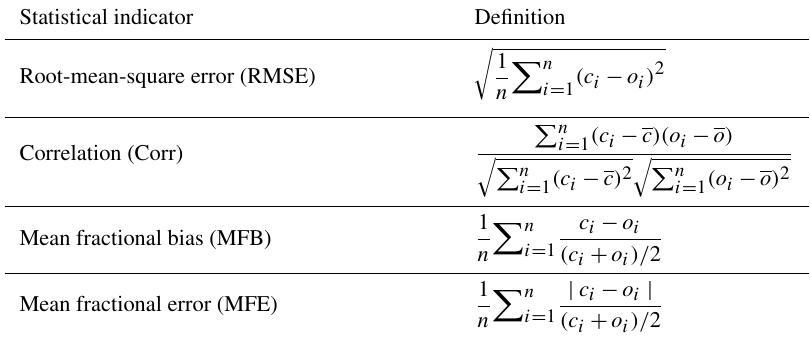
Table A1. Definitions of the statistics used in this work. (o i ) i and (c i ) i are the observed and the simulated concentrations at time and location i , respectively. n is the number of data.